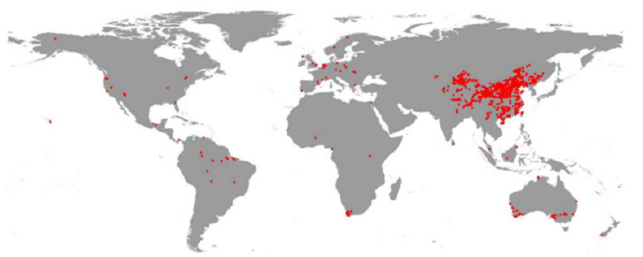
Figure 1. The distribution of studied sites [4]. Red plots represent the study locations for the leaf N and P and the N:P ratio.